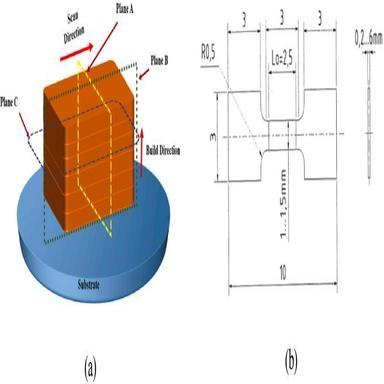
Systematic of (a) different sample cutting plane (b) Micro-tensile miniature specimen.